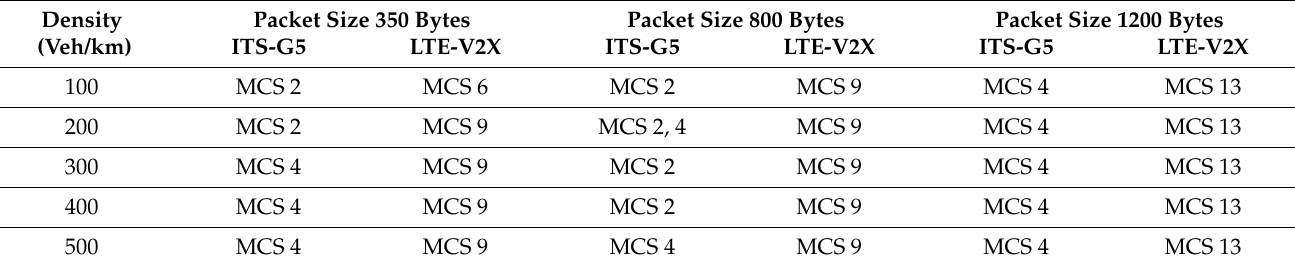
Table 5. Optimal coding rate for PRR ≥ 90%.